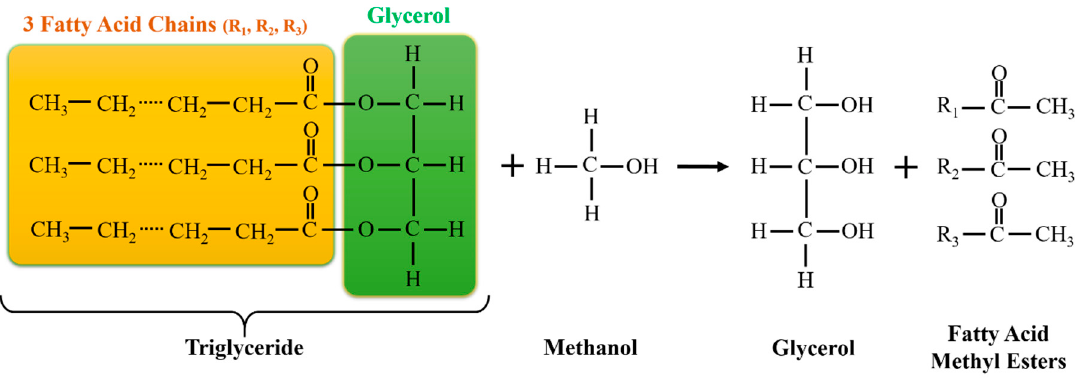
Figure 1. Production of glycerol from the transesterification of triglycerides [20] (redrawn with copyright permission) .